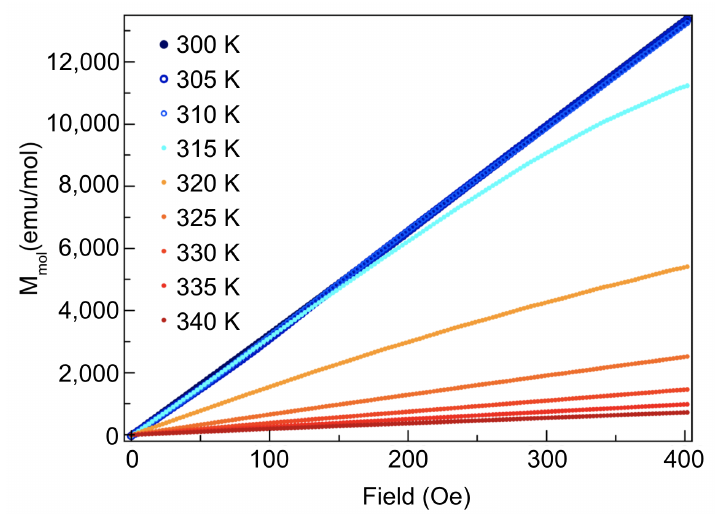
Figure 5. Magnetic field-dependent magnetization upon increasing magnetic fields from 0 Oe to 400 Oe for a temperature range of 300 K–340 K in 5 K increments. Low–high temperature corresponds to blue–red curves. Note a substantial decrease in magnetization for temperatures greater then 320 K, consistent with a paramagnetic